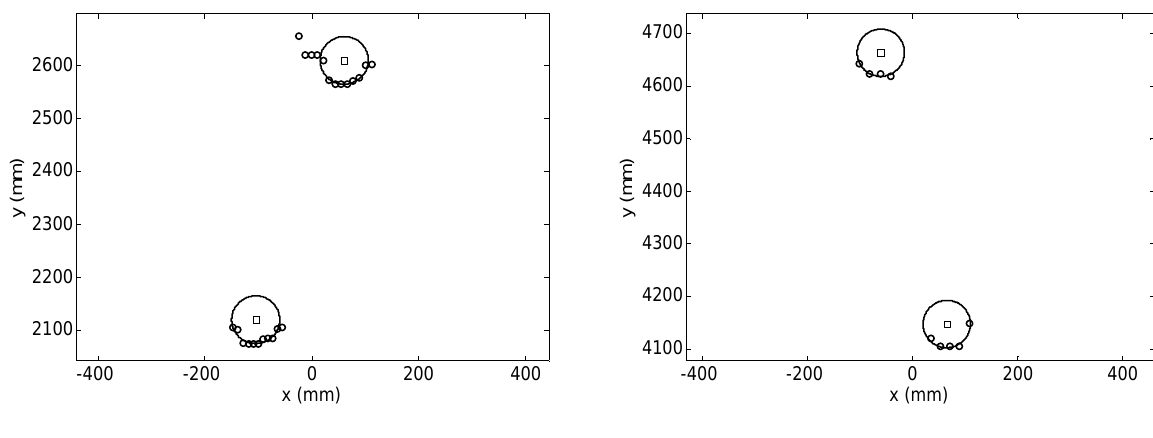
Figure 7. Example of an outlier point originated by the detection of the